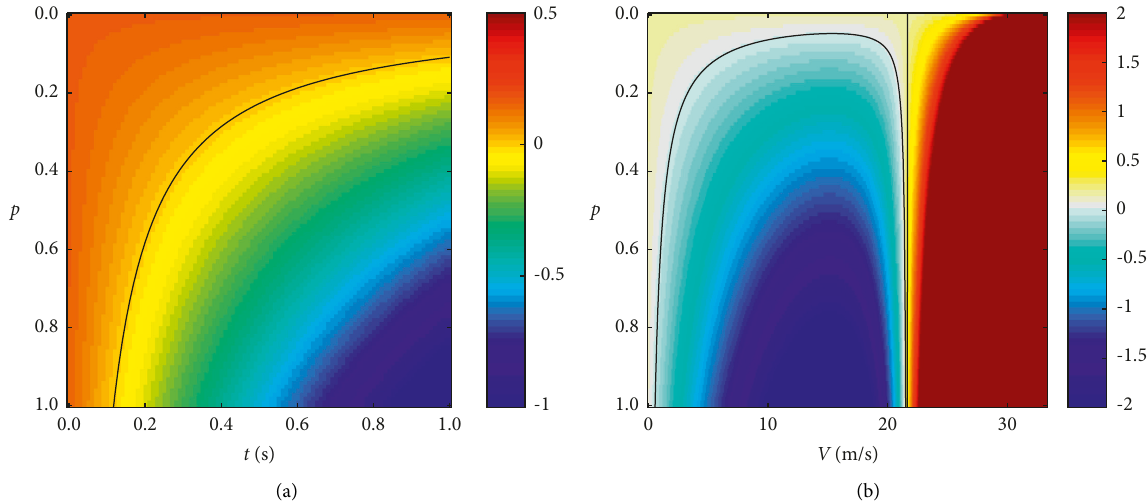
Figure 5: Stability values for heterogeneous traffic flow with extreme values of q . (a) q � 0. (b) q �